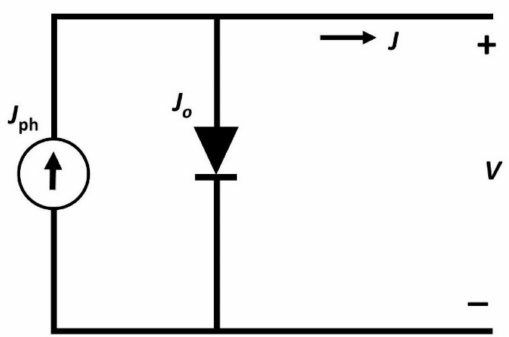
Figure 2. Equivalent electrical circuit diagram for a solar cell under